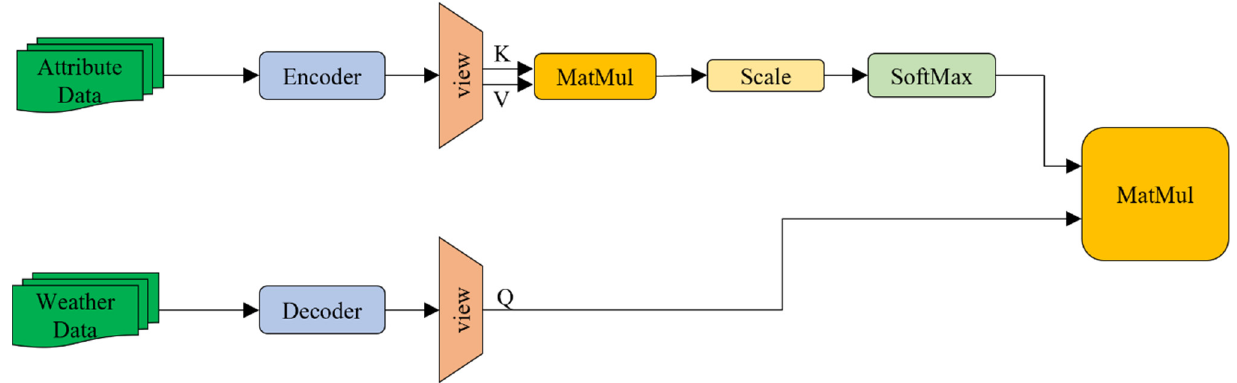
Figure 4. Schematic of environmental data features mapping module.